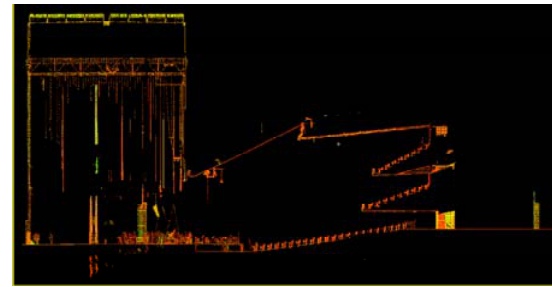
Figure 2. Point Clouds in “Big Auditorium Guairão” Longitudinal Section